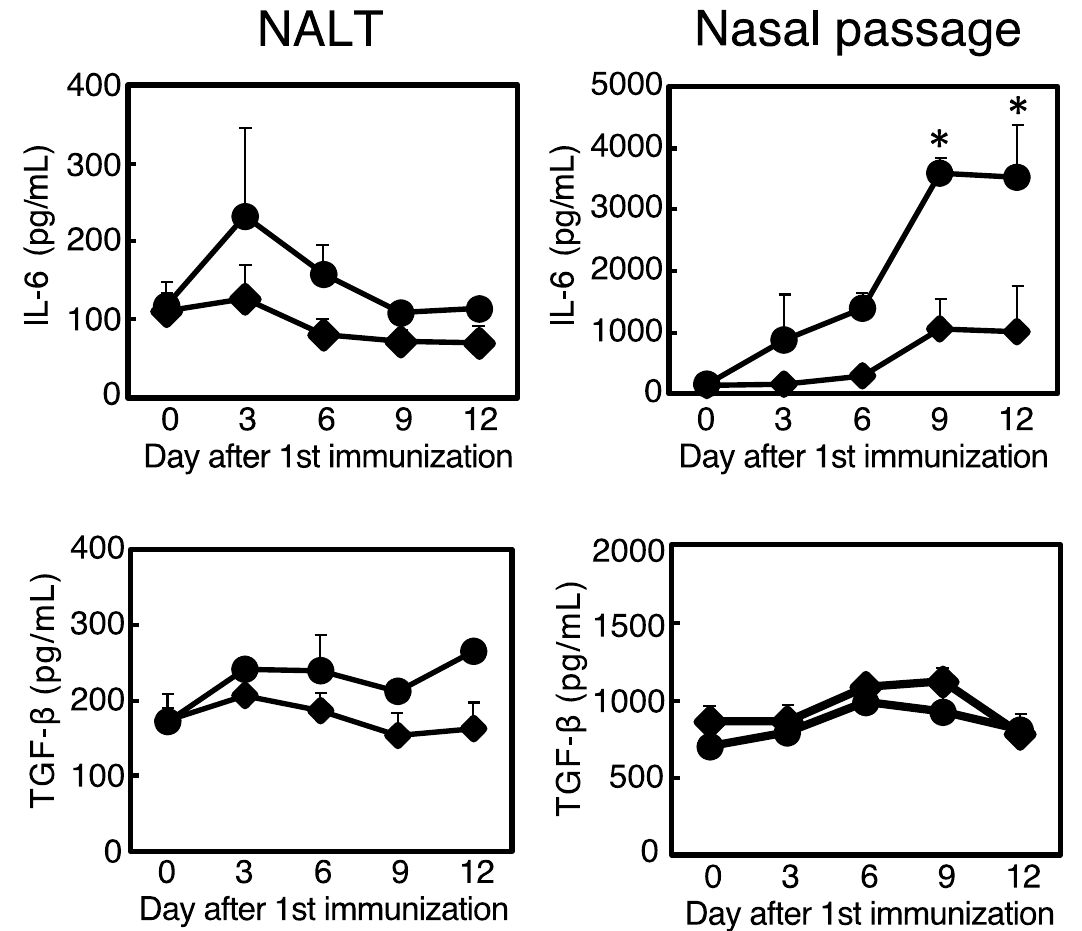
Figure 1. Production of interleukin (IL)-6 and transforming growth factor-beta (TGF- β ) in nasal- associated lymphoid tissues (NALTs) and nasal passages from mice nasally immunized with CpG oligodeoxynucleotide (ODN)-loaded cationic liposomes in combination with ovalbumin (OVA) ( ◆ ), or CpG ODN in combination with OVA ( ● ). NALTs and nasal passages were harvested 0, 3, 6, 9, or 12 d after immunization. After extraction, the levels of IL-6 and TGF- β were analyzed using an enzyme-linked immunosorbent assay (ELISA). Cytokine levels represent the mean ± standard deviation of biological triplicates. CpG ODN plus OVA, n = 3; CpG ODN-loaded cationic liposomes plus OVA, n = 3. Significant differences were calculated using an unpaired t -test with Welch’s correction. * p < 0.05.